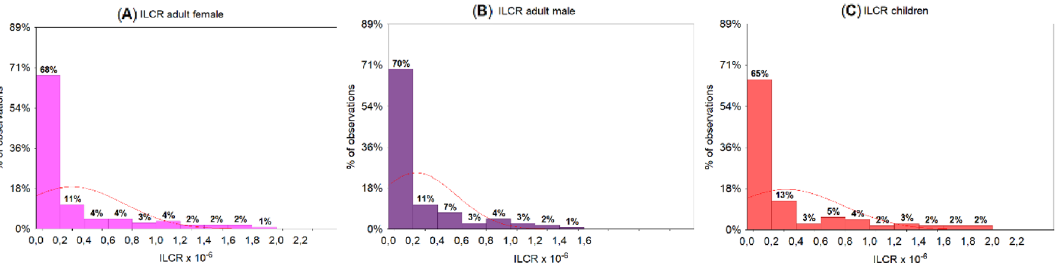
Figure 5. Histogram plots of ILCR frequency distribution (× 10 −6 ) in three different population groups: ( A ) adult females, ( B ) adult males, and ( C )